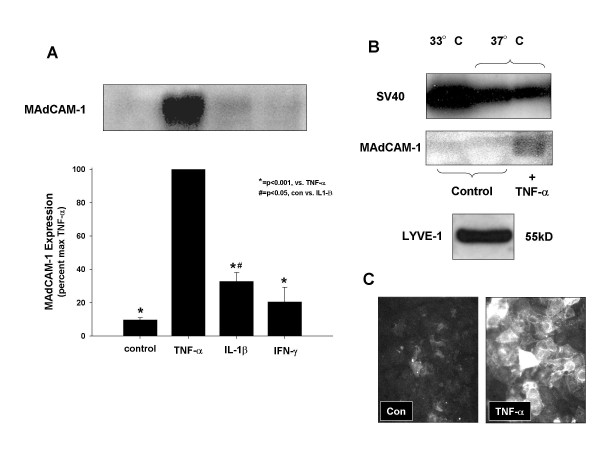
MAdCAM-1 is expressed by cytokine activated hepatic endothelial cells. A. Hepatic endothelial cells were treated with TNF-α (20 ng/ml), or IL-1β (10 ng/ml) or IFN-γ (1000 u/ml) for 24 h. B. Immunoblotting for SV40 Large-T antigen and MAdCAM-1 C. Immunostaining for MAdCAM-1 on the HEC cell surface.